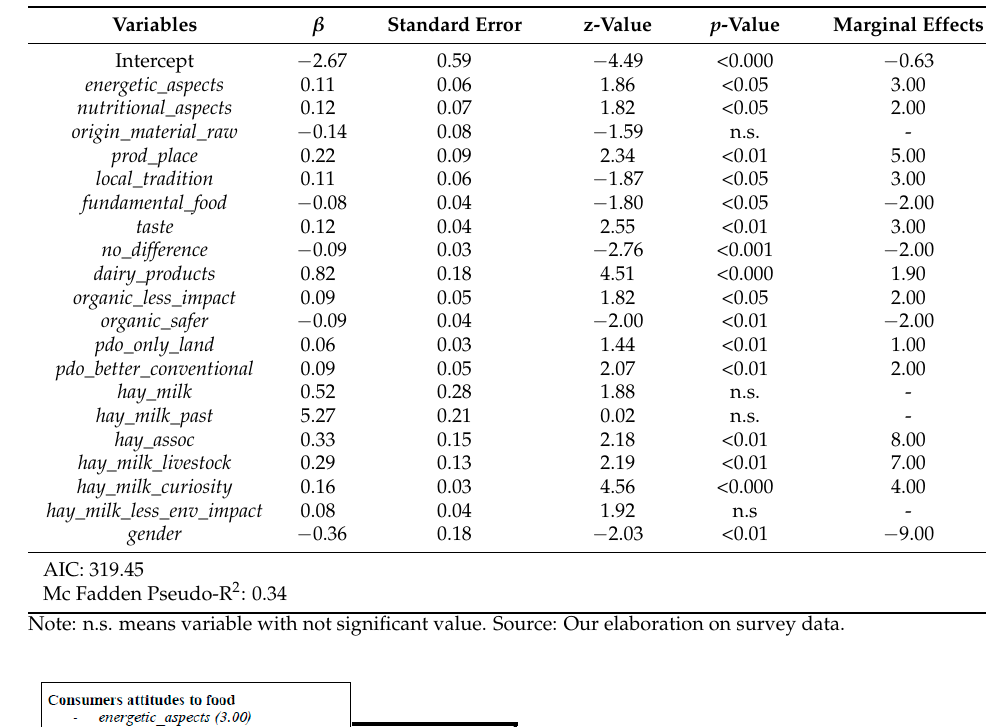
Table 2. Estimates of the binary probit model ( n = 331).